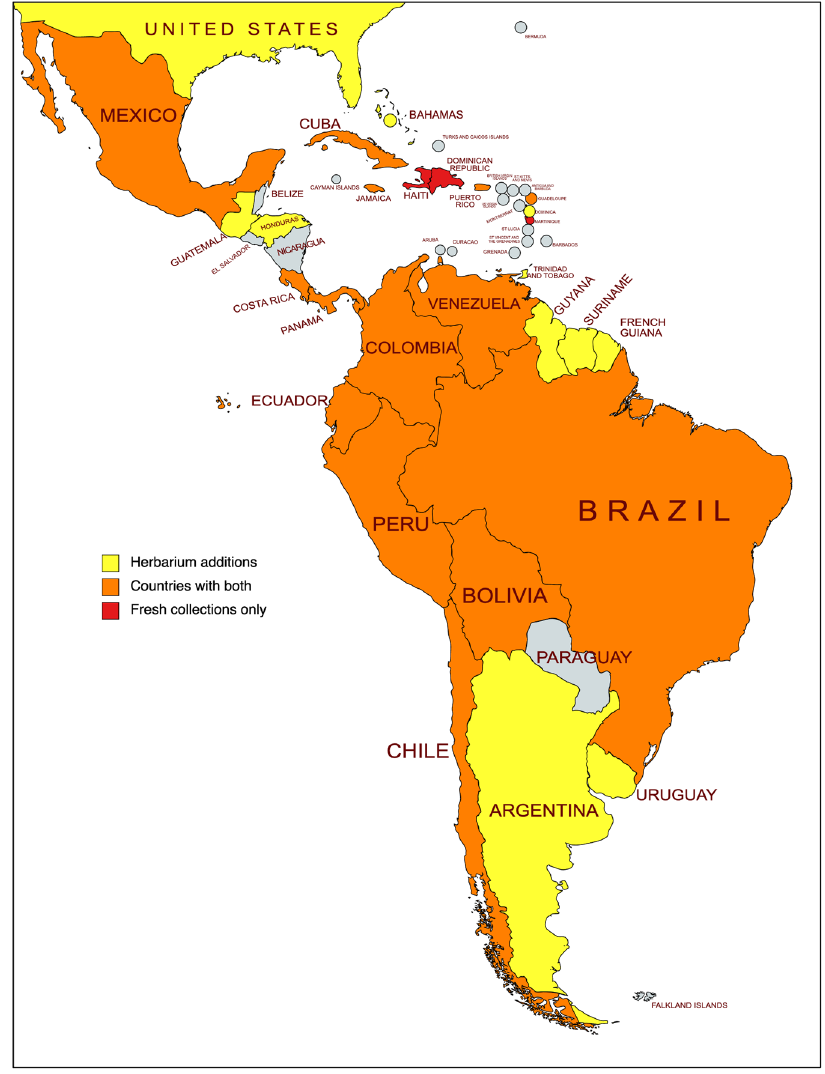
Figure 2. Map showing country-based availability of sequenced contemporaneous (fresh) and historical (herbarium) samples of Cora (and Corella ) throughout the Americas (generated with mapchart.net).